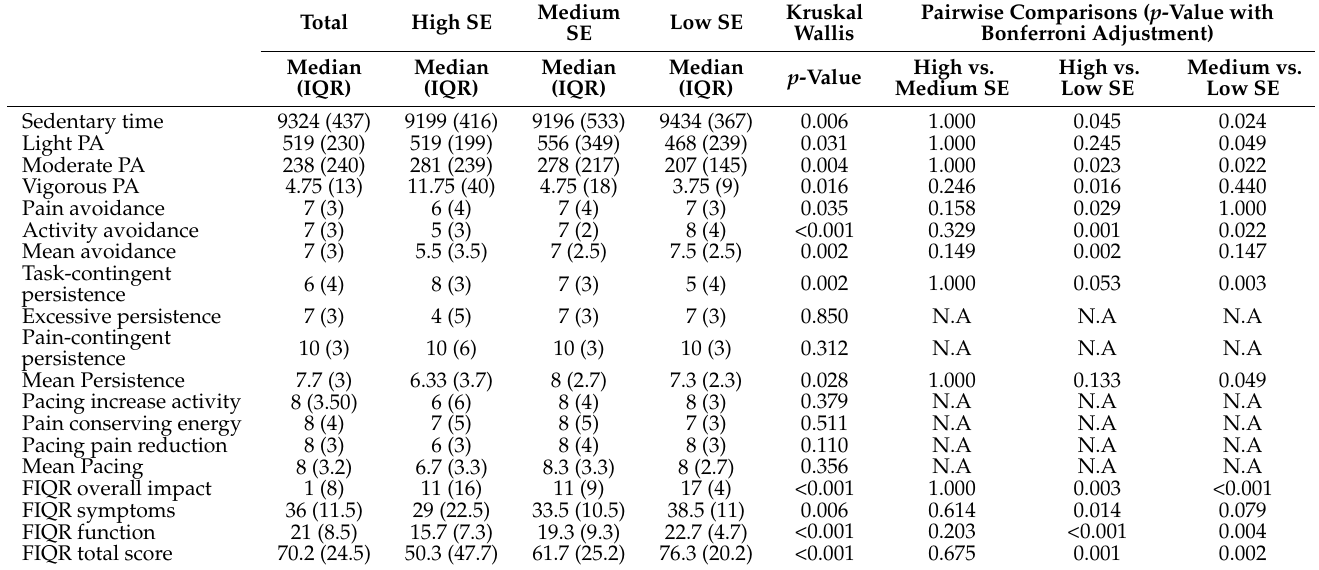
Table 5. Results of the analyzed variables regarding the self-efficacy for physical activity